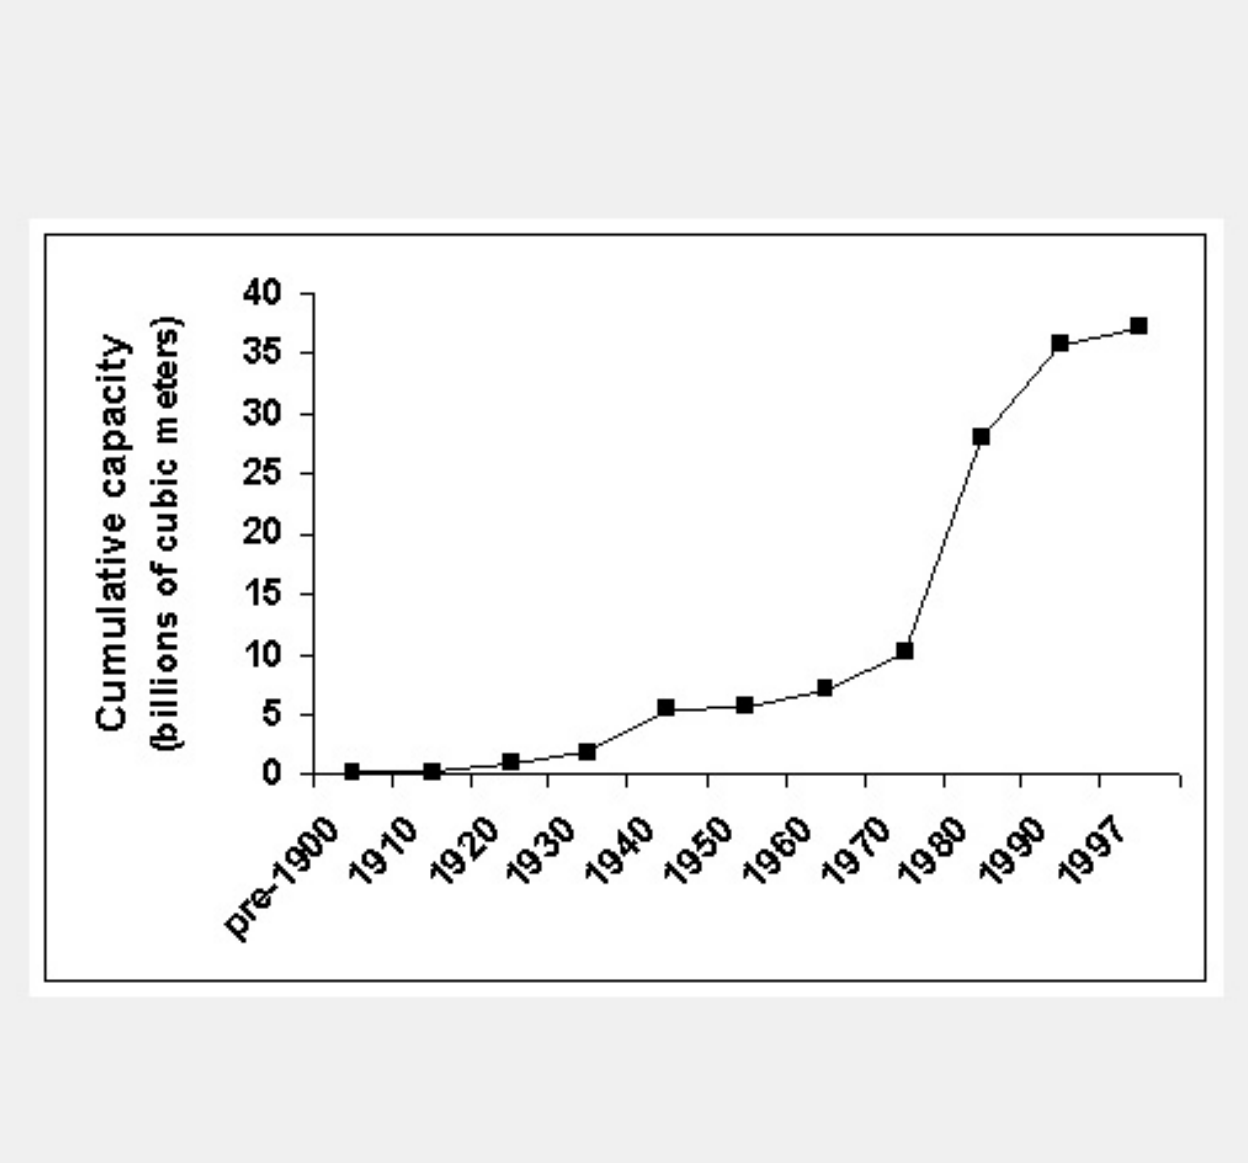
Fig. 3. Water supply augmentation, illustrated by cumulative storage-dam capacity in South Africa from pre-1900 until 1997 (Aquatic Resource Management for Local Communities